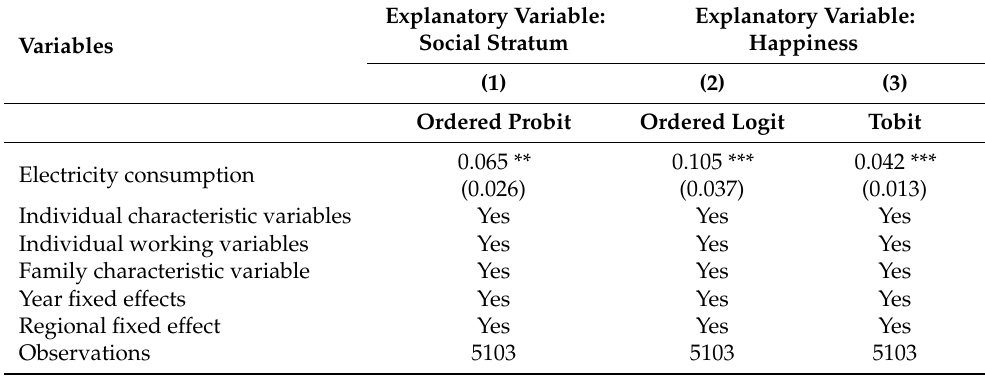
Table 4. Robustness